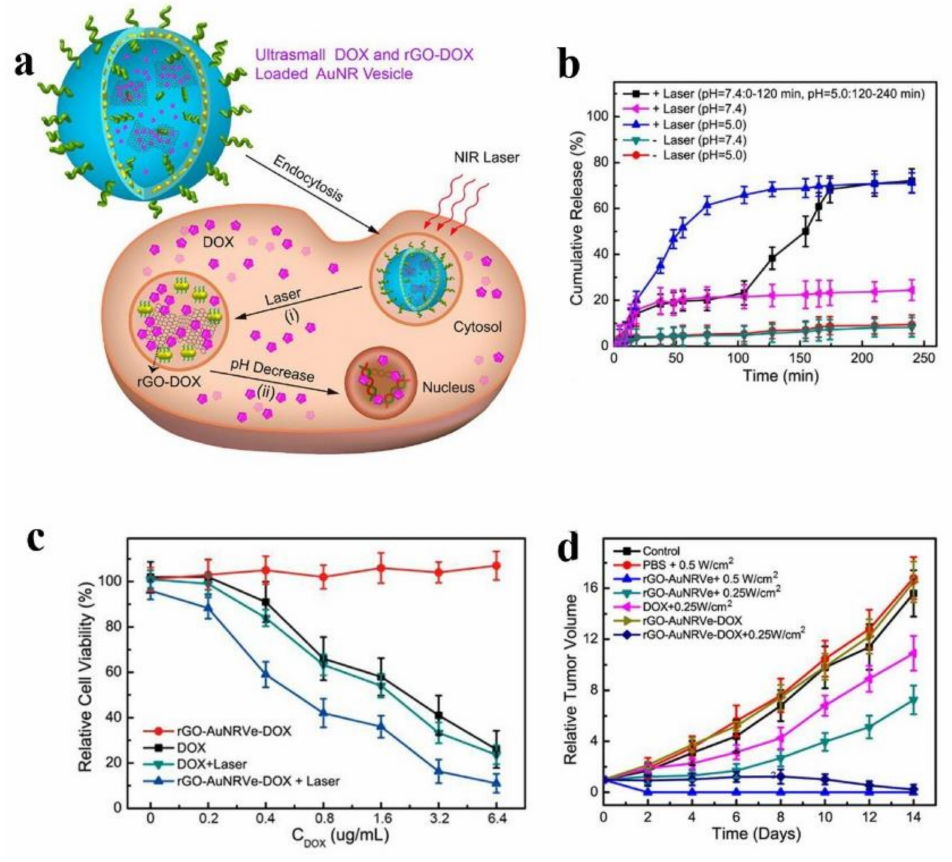
Figure 6. ( a ) Schematic illustration of the sequential drug release in vitro; ( b ) Stimuli-responsive DOX release profiles of different samples irradiated with or without NIR laser irradiation in pH = 5.0 or pH = 7.4 aqueous solution; ( c ) Cell viability of U87MG cancer cells treated with